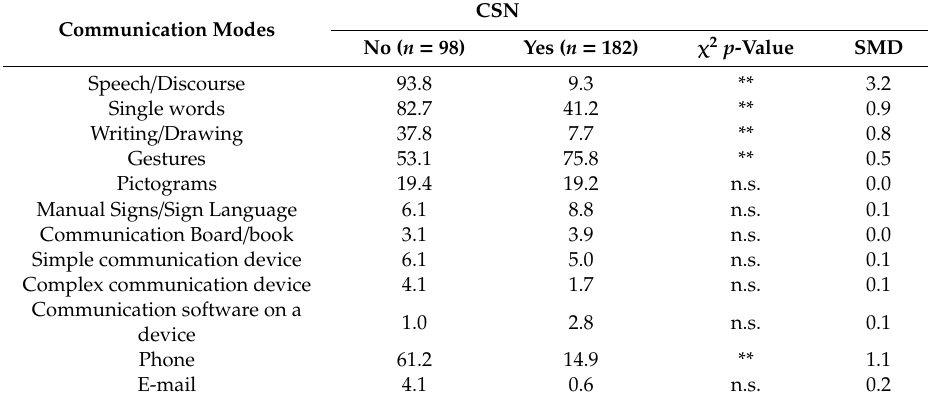
Table 2. Participants who use di ff erent communication modes as a percentage of each communication support needs (CSN) group.